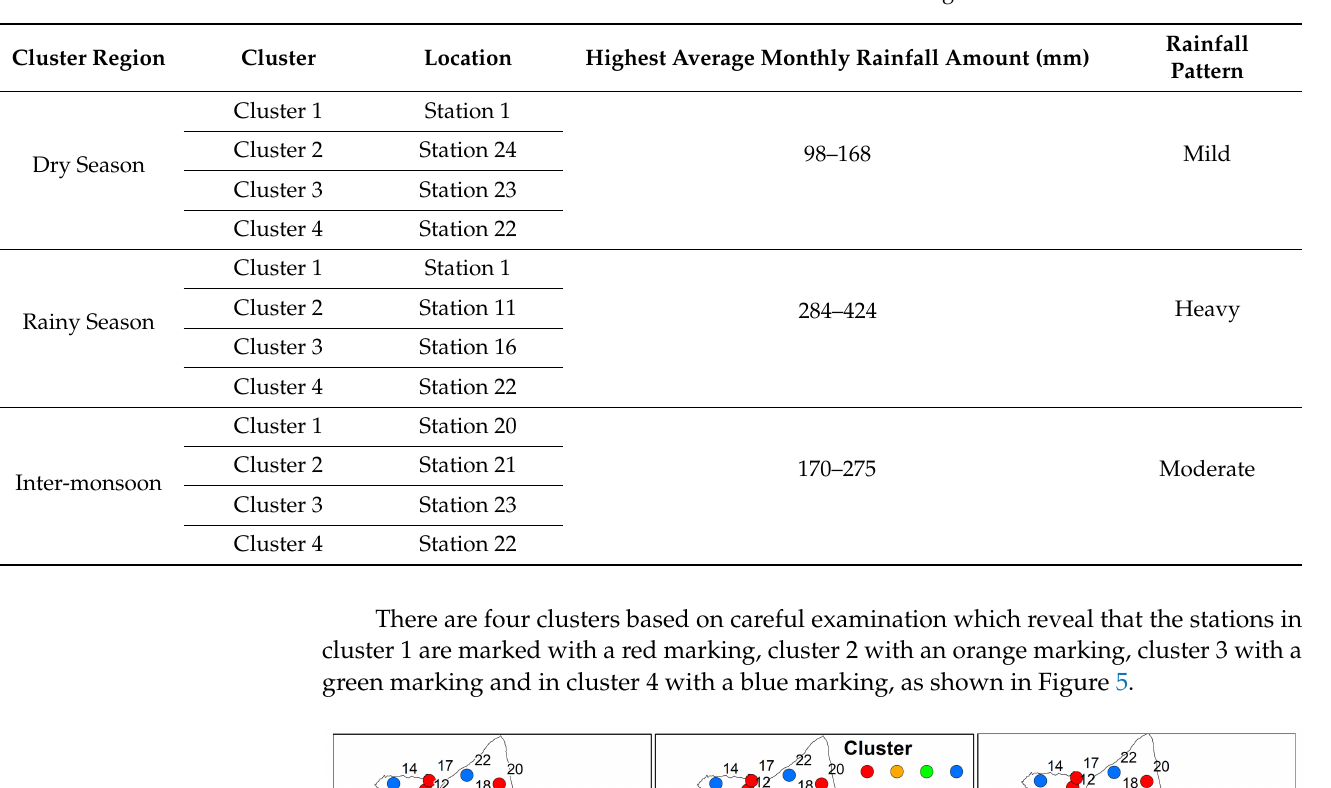
Table 3. The seasonal rainfall amount within four clusters in a region.